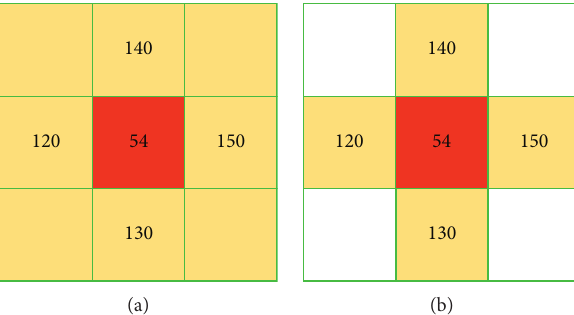
Figure 2: The selection of the candidate area during percolation: (a) eight neighbouring pixels’ region; (b) four neighbouring pixels’